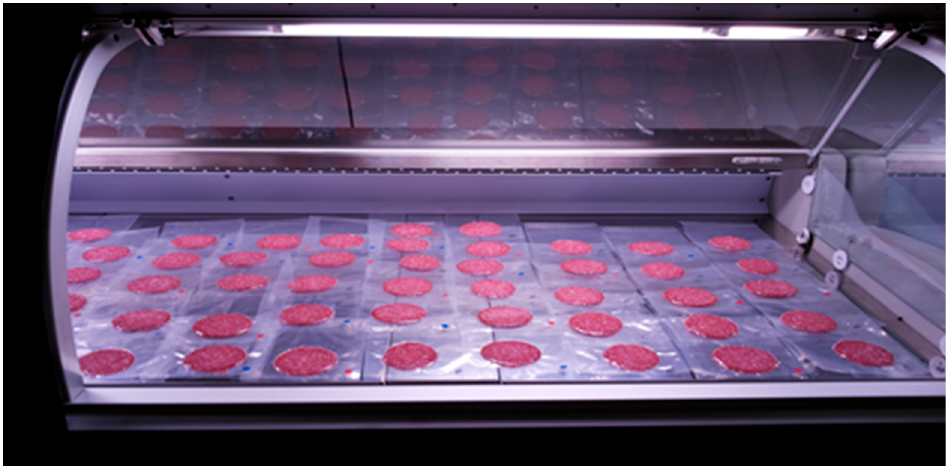
Figure 1. Light exposure of vacuum-packed salami in commercial display cabinets during refrigerated storage.